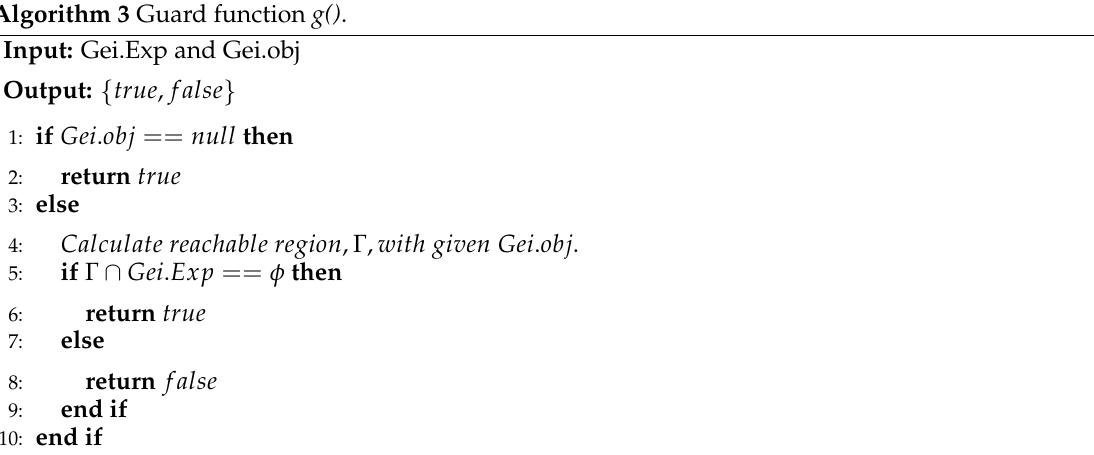
Algorithm 3 Guard function g()